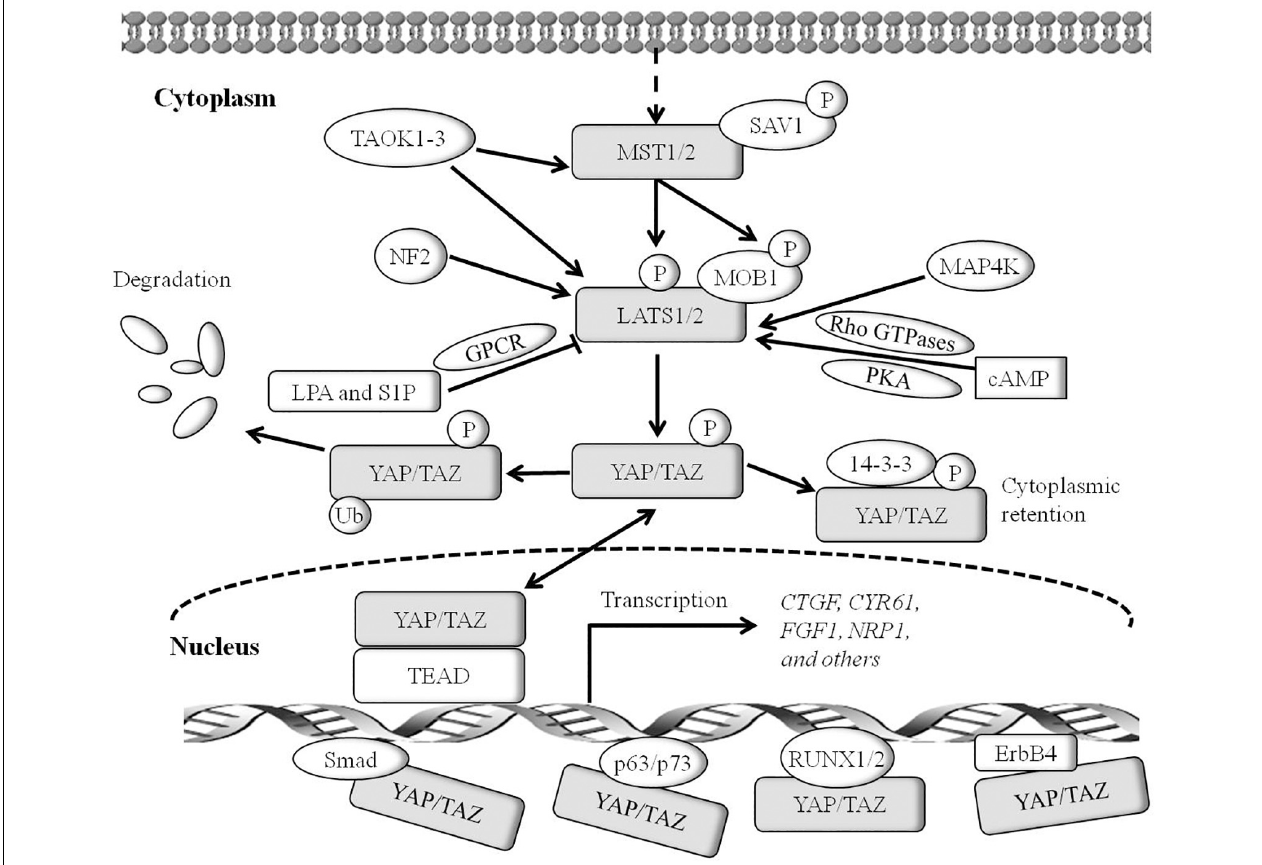
FIGURE 1 | The core Hippo pathway in mammals. Tao kinases 1–3 phosphorylate and activate MST1/2. Interactions between MST1/2 and SAV1 induce LATS1/2 activity. Phosphorylation of MOB1 by MST1/2 enhances MOB1 interactions with LATS1/2, leading to full activation of LATS1/2. NF2 interacts with LATS1/2 and facilitates LATS1/2 phosphorylation by the MST1/2-SAV1 complex. Members of the MAP4K family are identified as direct LATS1/2 activated kinases. cyclic adenosine monophosphate (cAMP) can also activate LATS1/2 kinases via protein kinase A (PKA) and Rho GTPases, whereas LPA (lysophosphatidic acid) and S1P (sphingosine 1- phosphophate) are shown to inhibit the activity of LATS1/2 kinases via G protein coupled receptor (GPCR). Phosphorylation of YAP on Ser 127 (TAZ on Ser 89 )induces binding of YAP (TAZ) with 14-3-3, and induces cytoplasmic retention of YAP (TAZ). Phosphorylation of YAP on Ser 381 (TAZ on Ser 311 ) triggers subsequent phosphorylation by casein kinase 1 (CK1 δ / ε ), resulting in the recruitment of SCF β -TRCP E3 ligase and ubiquitination, and the proteasomal degradation of YAP. TEADs are the major transcriptional activator of YAP in mammals, and YAP binding to TEADs is required for inducing target gene expression. Smad, RUNX1/2, p63/p73, and ErbB4 may be transcriptional factors of YAP/TAZ. YAP and TEADs mediate the expression of target genes such as CTGF , CYR61 , Birc5 , FGF1 , RASSF1A, and